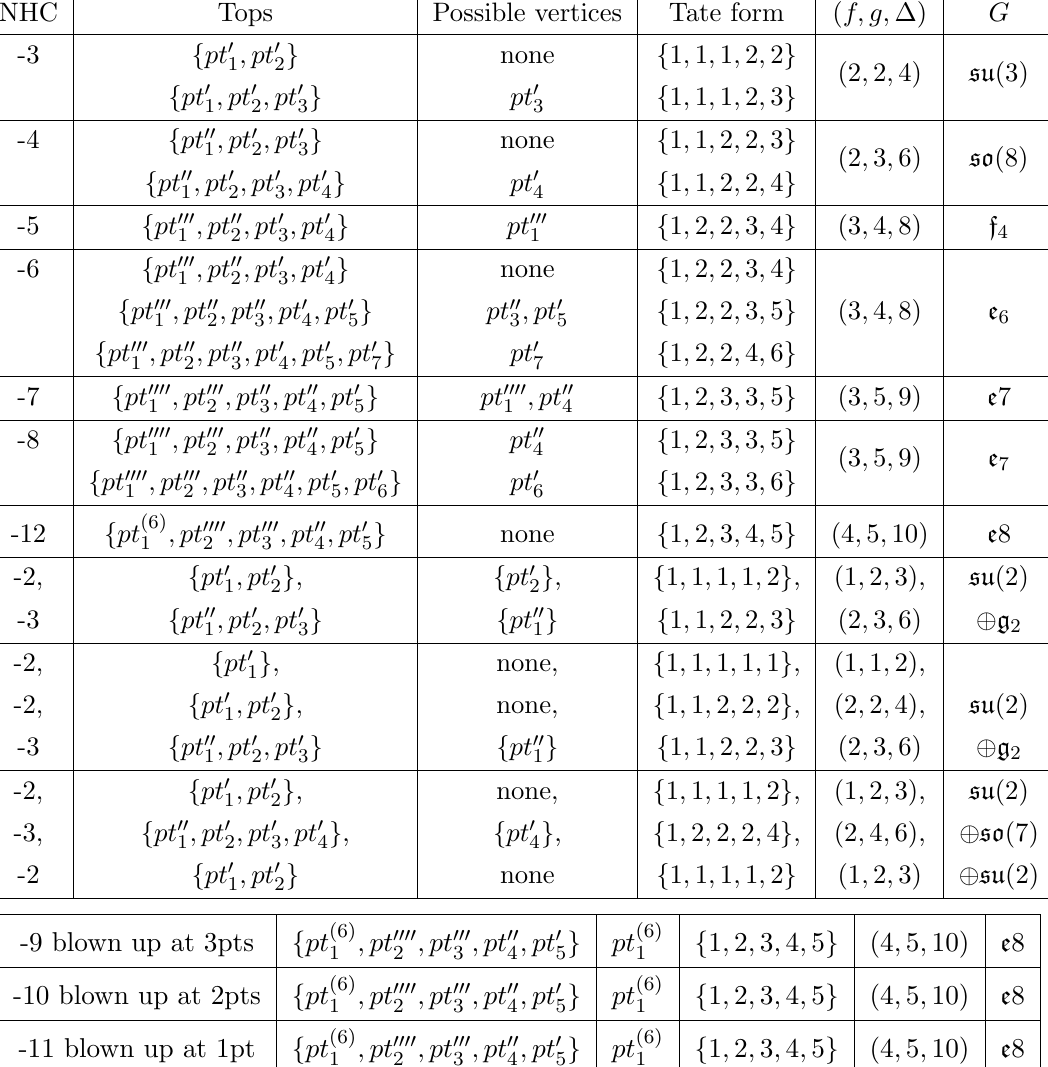
Table 11. Tops over NHCs and the corresponding Tate vanishing orders. In each case the (cid:12)rst example is the top and associated minimal Tate tuning associated with the \dual of the dual" construction described in section